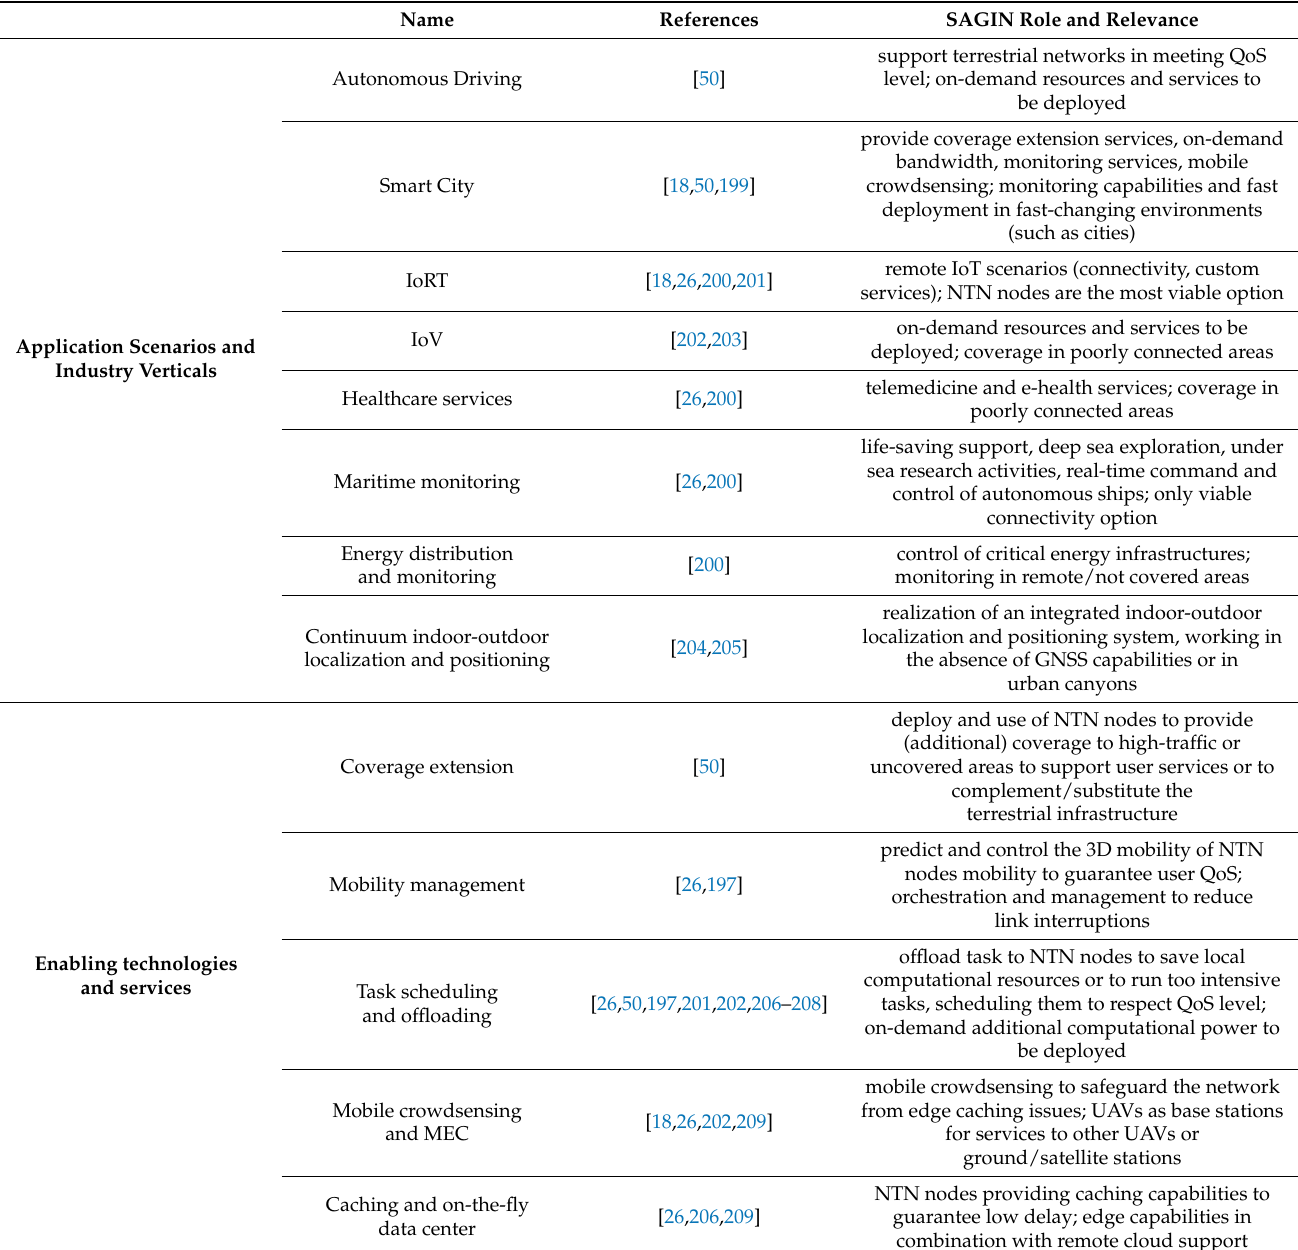
Table 5. SAGIN-related relevant scenarios and enabling technologies in the